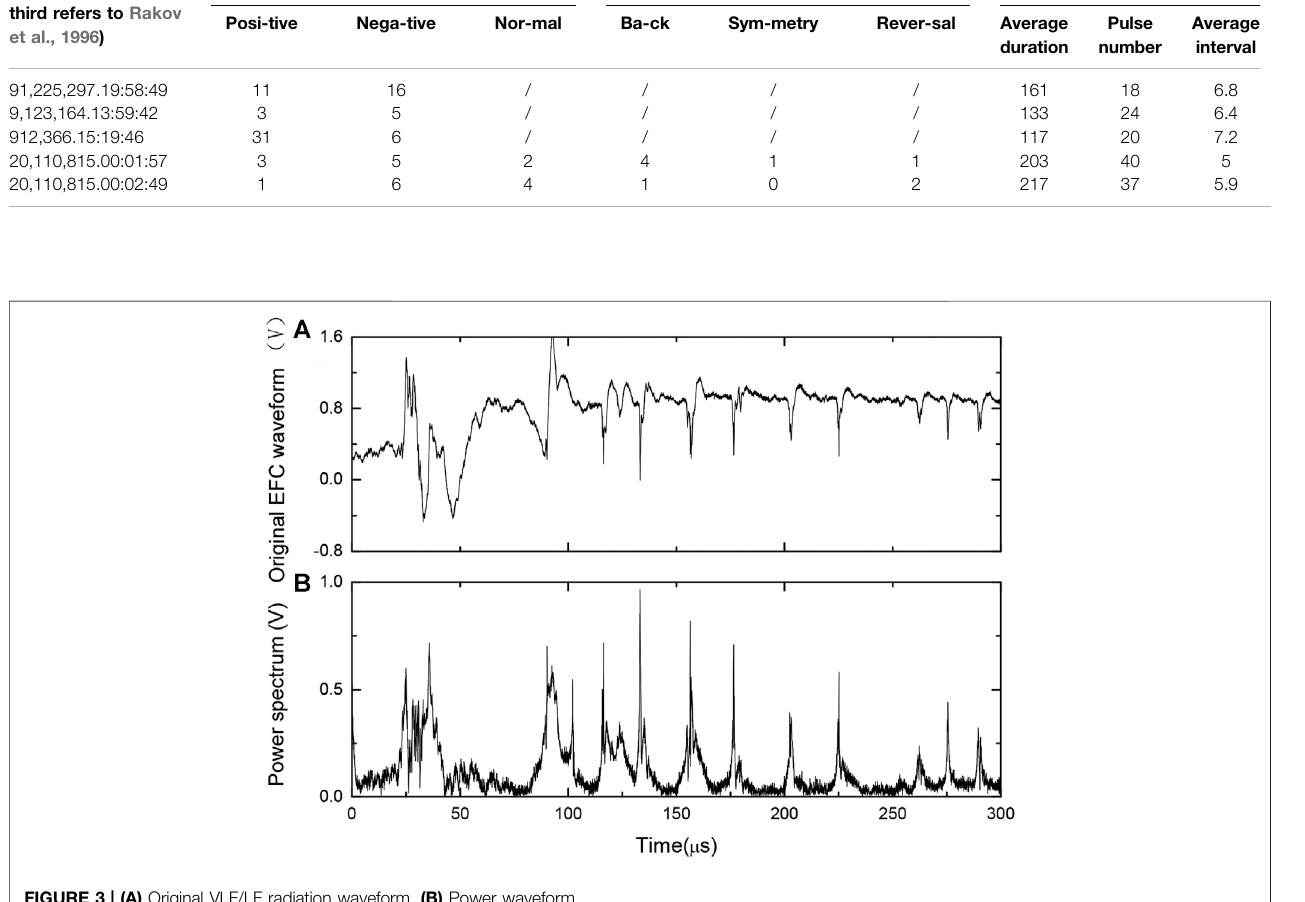
Frontiers in Environmental Science |